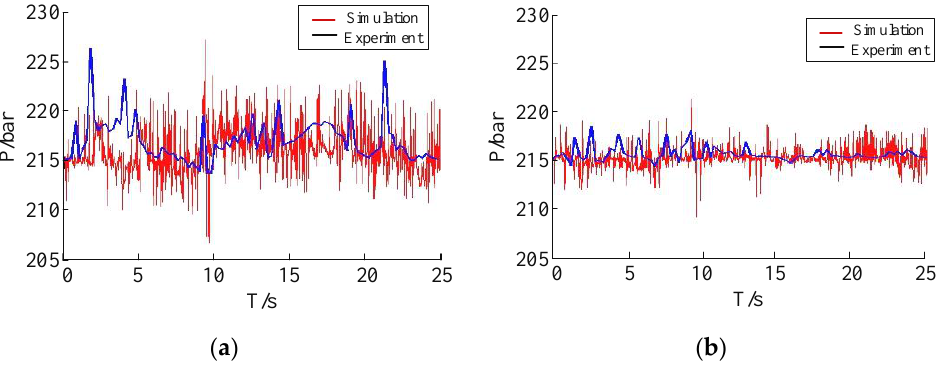
Figure 16. The pressure of one cylinder: ( a ) Accumulator off; ( b ) accumulator on.